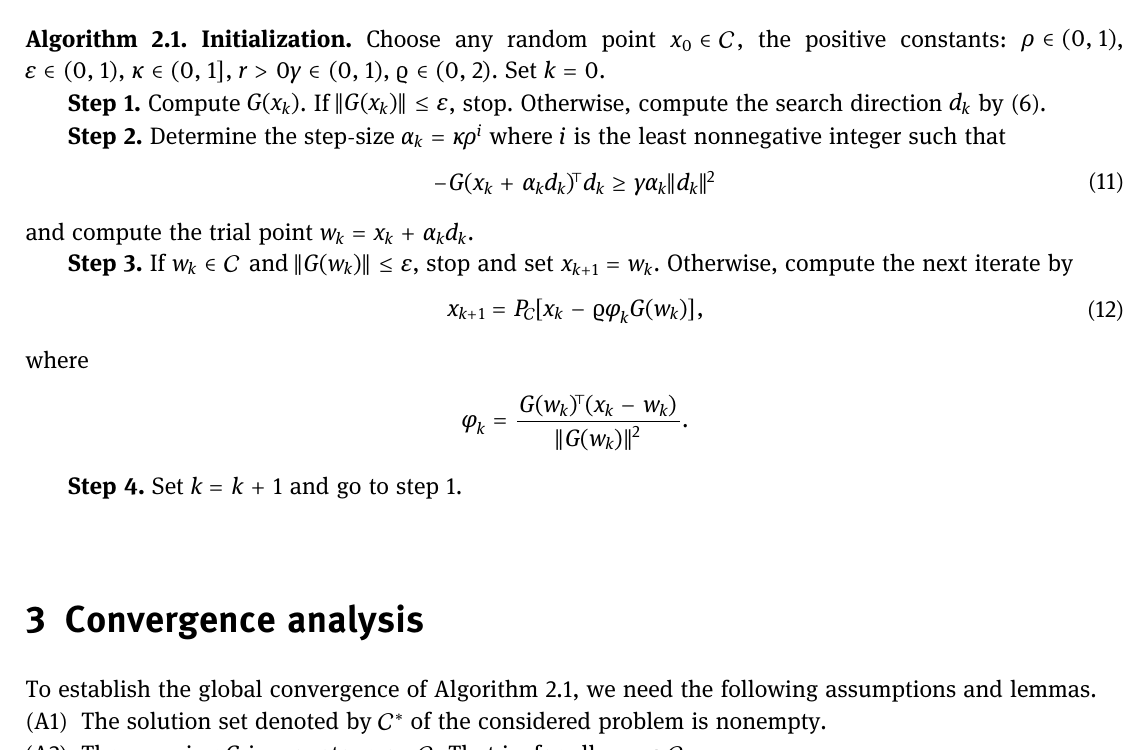
Algorithm 2.1. Initialization. Choose any random point x